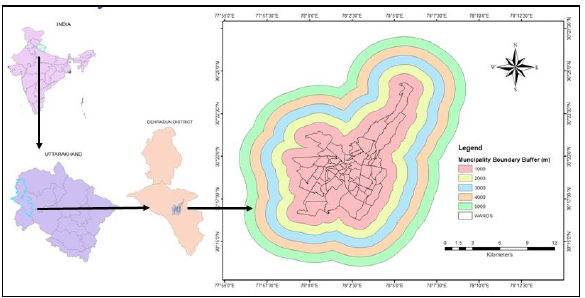
Figure 1. Study area